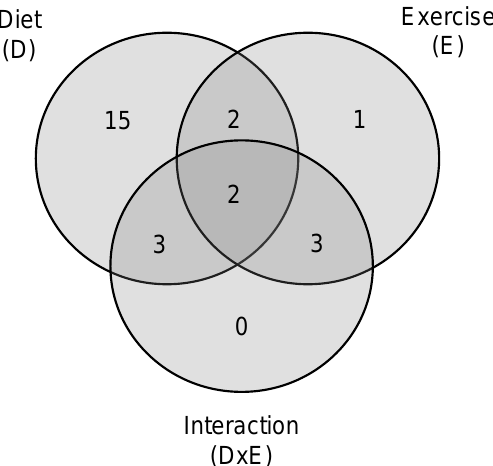
Figure 1. Venn diagram showing the number of serum Lyso-PLs for each experimental factor. Data were analyzed using two-way ANOVA. D: the effect of diet; E: the effect of exercise; DxE: the interaction between the two main factors ( p < 0.05). The areas where the circles overlap show the number of significant lyso forms shared by the factors. The flowchart of the experimental design is showed in Supplementary Materials, Figure S1.